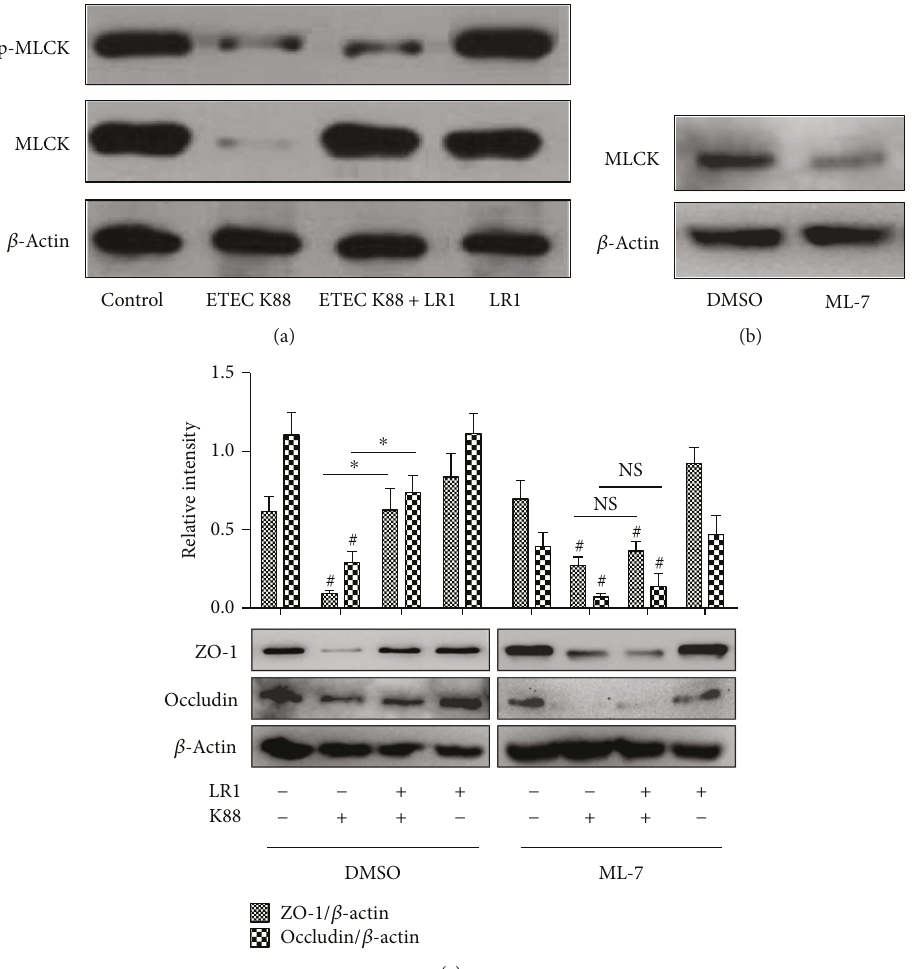
Figure 4: L. reuteri LR1 improved content of TJ proteins in a MLCK-dependent manner. (a) Content of MLCK and phosphorylated MLCK as in fl uenced by ETEC K88 with and without L. reuteri LR1 in IPEC-1 cells, by Western blotting. (b) Inhibiting e ff ect of the selective inhibitor ML-7 on the action of L. reuteri LR1 on MLCK in IPEC-1 cells. (c) Content of ZO-1 and occludin in IPEC-1 cells with ML-7 treatment. All data are expressed as the mean ± SEM ( n = 6 ) and representative of 3 independent experiments. Di ff erences were determined by one-way ANOVA. # P < 0 05 compared with control, ∗ P < 0 05